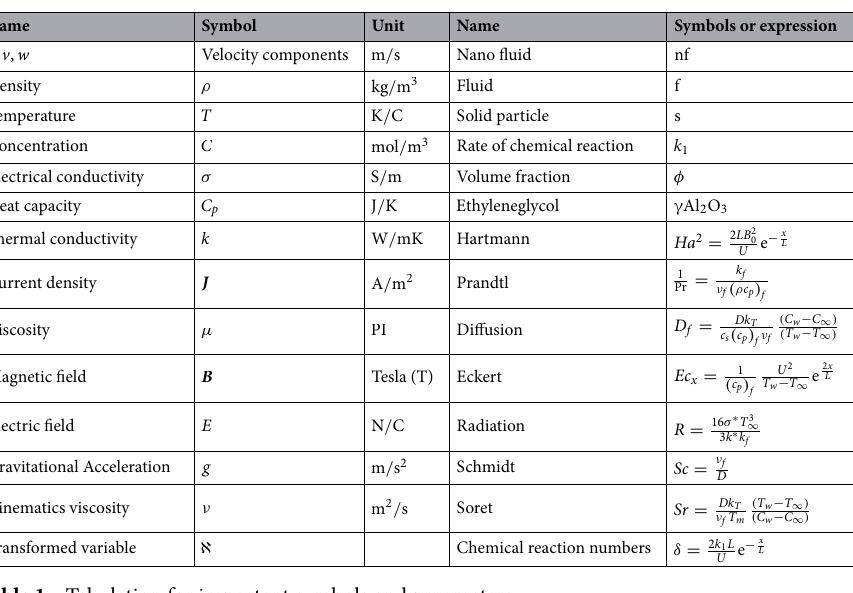
Table 1. Tabulation for important symbols and